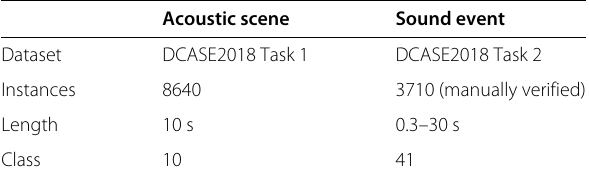
Table 2 Setting of experiment